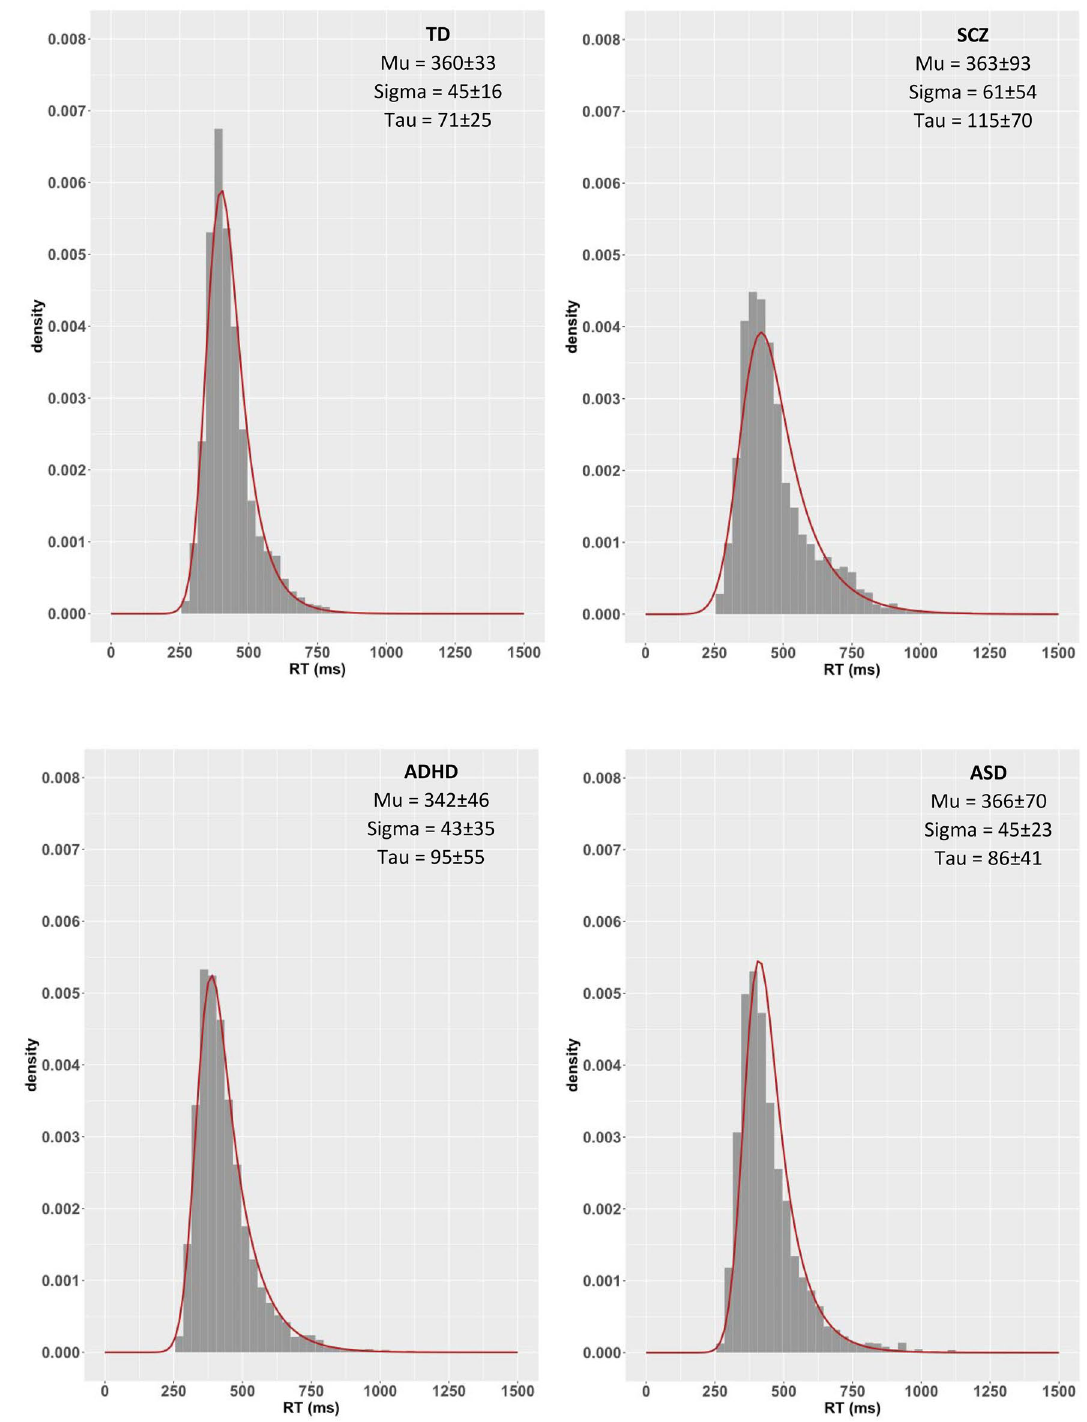
Figure 3. The four plots show the RT distributions in the four groups in GNG. The RT are plotted in the x-axis and the density in the y-axis. The ex-Gaussian model fit on the RT distribution is also plotted (red line), and is calculated based on the average of each ex-Gaussian parameter from all participants, separately for the three parameters and the four groups. Graphs were created using the ggplot2 package for the open-source statistical package RStudio. The effect sizes from the between-group subject ANOVA are also reported here. Mu: η p2 = 0.026, Sigma: η p2 = 0.041, Tau: η p2 =